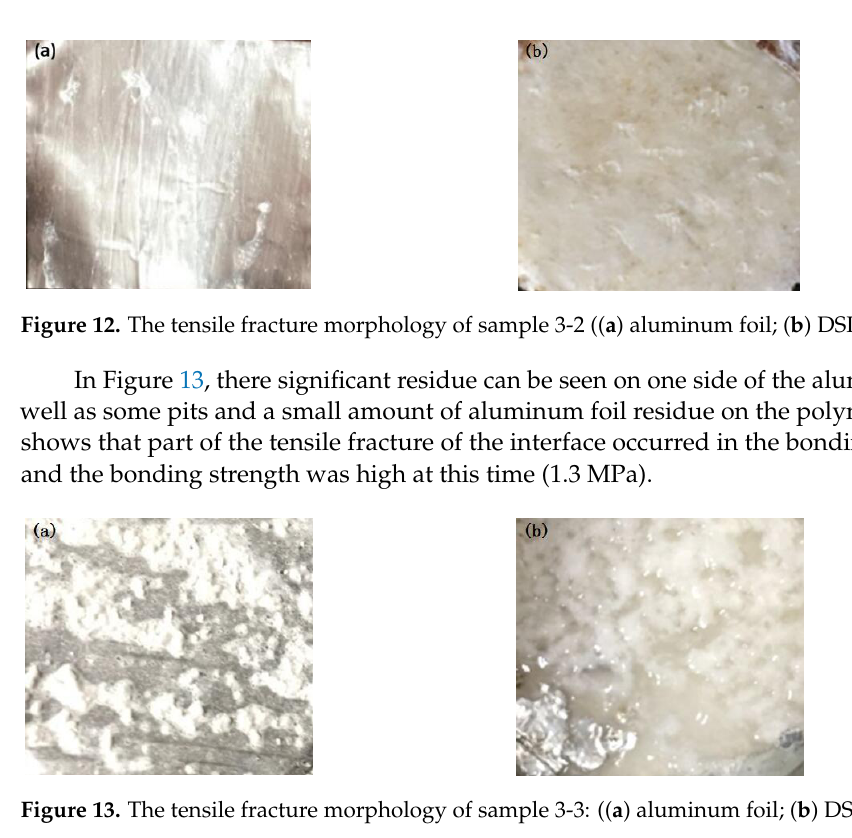
Figure 11. The tensile fracture morphology of sample 3-1: (( a ) aluminum foil; ( b ) DSPE).